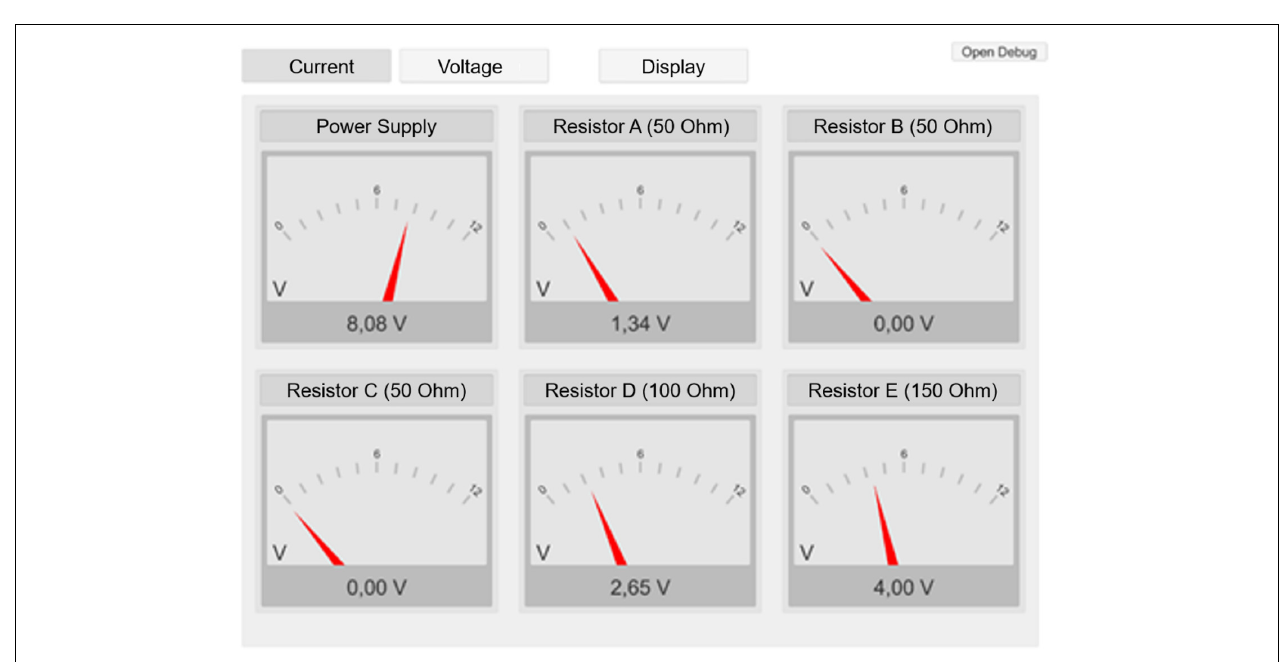
FIGURE 2 | Illustration of the experimental setup with the matrix visualization on a tablet for the separate-display condition.